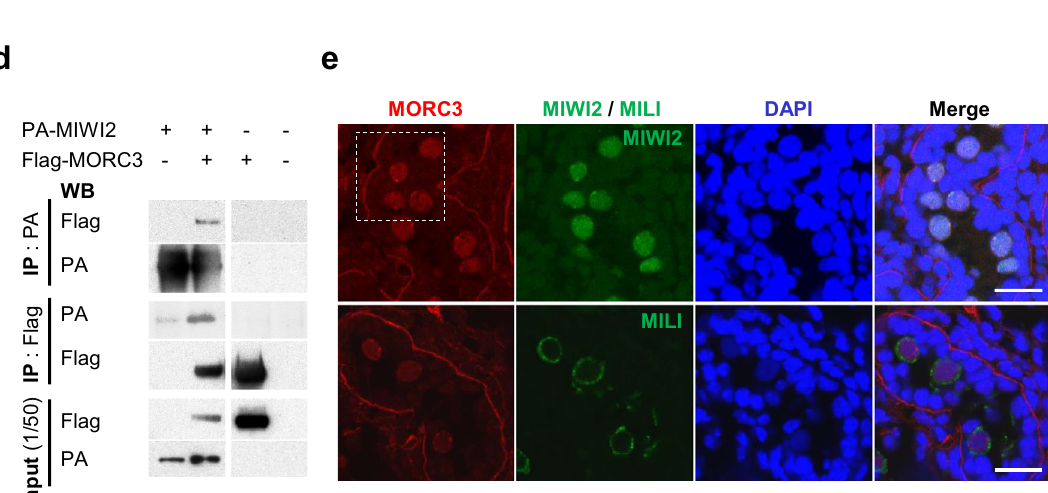
Figure 1. MORC3 as an interaction partner of MIWI2. ( a ) Silver staining of the postnatal testis proteins that co-immunoprecipitated with the anti-Flag antibody. Testis lysates of 21-day-old ZF only and ZF-MIWI2 Tg mice were subjected to IP (immunoprecipitation) with the anti-Flag antibody and SDS–PAGE was carried out. The 130 kDa protein that bound specifically to MIWI2 (black arrow) was examined by LC–MS/MS. Uncropped gel was shown in Supplementary Figure S1a. ( b ) Binding of ZF-MIWI2 to MORC3 in embryonic testes. IP of the embryonic testes lysates of E16.5 wild type and ZF-MIWI2 Tg mice was carried out with the anti-Flag antibody. The immunoprecipitated MORC3, ZF-MIWI2, and MIWI2 proteins were detected using the corresponding antibodies in western blotting. All samples were run on the same gel and transferred. Uncropped blots were shown in Supplementary Figure S1b. ( c ) Interaction of endogenous MIWI2 to MORC3 in embryonic testes. IP of the embryonic testes lysates of E16.5 wild type mouse was carried out with the anti-MORC3 antibody. The immunoprecipitated MIWI2 and MORC3 proteins were detected using the corresponding antibodies by western blotting. All samples were run on the same gel and transferred. Uncropped blots were shown in Supplementary Figure S1c. ( d ) In vitro co-IP assays for MIWI2 and MORC3. HEK 293T cells were transfected with the plasmids expressing PA-tagged MIWI2 and Flag-tagged MORC3. The 293T cells were co-transfected with the tagged protein expression constructs. The lysates were immunoprecipitated with the anti-PA or anti- Flag antibodies and subsequently subjected to western blotting with these antibodies. Each of IP : PA, IP : Flag, and input samples was run on the same gel and transferred. Uncropped blots were shown in Supplementary Figure S1d-i. ( e ) Co-immunostaining of the testes of the E17.5 wild type mice with the anti-MORC3 antibody (red), anti-MIWI2 (green) or anti-MILI (green) antibodies, and DAPI (blue) for DNA are shown. Scale bar, 20 μm. The enlarged images (inside of the white dotted line) are shown in Supplementary Figure